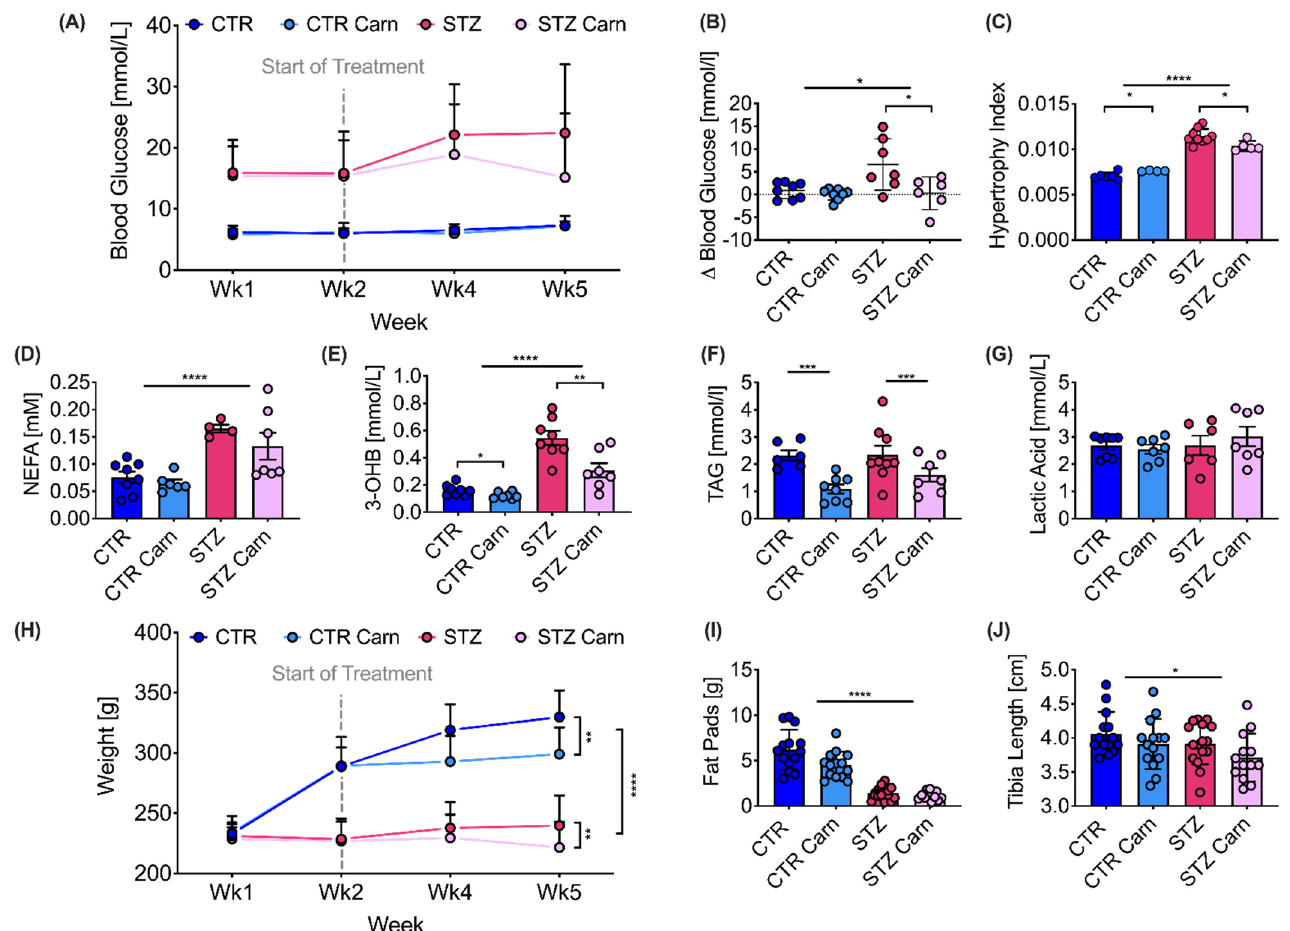
Figure 1. Carnitine induced changes in diabetes. Animal characteristics five weeks post streptozotocin-induced diabetes (STZ) or in citrate buffer injected controls (CTR), 50% of all animals were treated with L-carnitine (Carn) initiated at week 2. ( A ) Fasted blood glucose concentration at 1, 2, 4 and 5 weeks, **** between CTR and STZ groups at 1, 2, 4 and 5 weeks. ( B ) Delta blood glucose concentrations between week two and week five. ( C ) Kidney hypertrophy index assessed as kidney weight/body weight. ( D ) Non-esterified fatty acids (NEFA). ( E ) ß-hydroxybutyrate (3-OHB). ( F ) Triglycerides (TAG). ( G ) Lactic acid concentration. ( H ) Body weight measured at 1, 2, 4 and 5 weeks (Wk) post induction of diabetes. ( I ) Epididymal fat pads. ( J ) Tibia length. Data are presented as mean ± SD. Two-way ANOVA, if an interaction was found to be significant, the effect of L-carnitine on control and diabetes was evaluated using Sidak’s multiple comparison test. Significant differences are represented by ‘*’, with * p < 0.05, ** p < 0.01, *** p < 0.001, **** p < 0.0001.